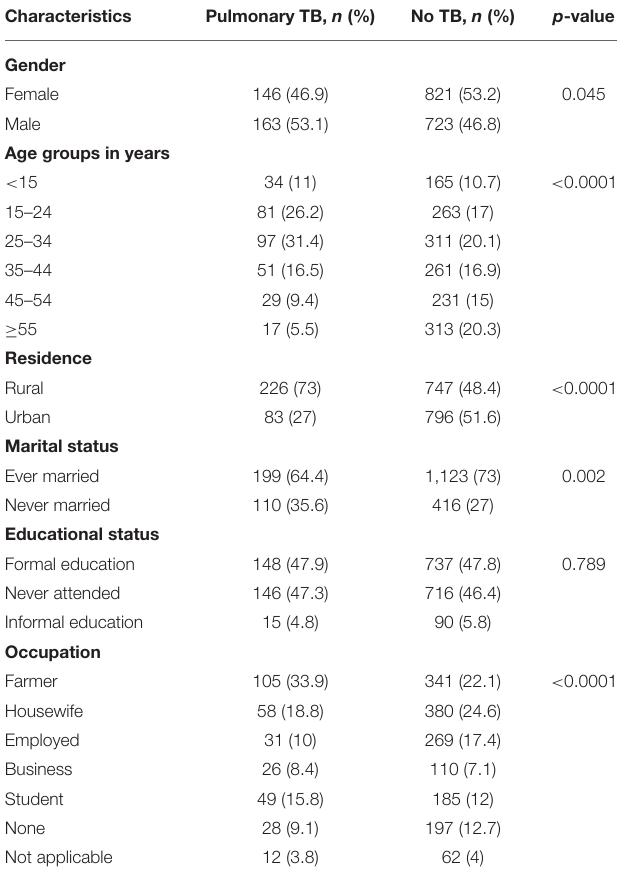
TABLE 1 | Socio-demographic variables associated to pulmonary TB among presumptive TB cases at health facilities, Ethiopia.